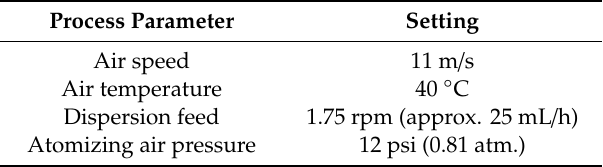
Table 3. The process parameters used for the drug layering of the inert